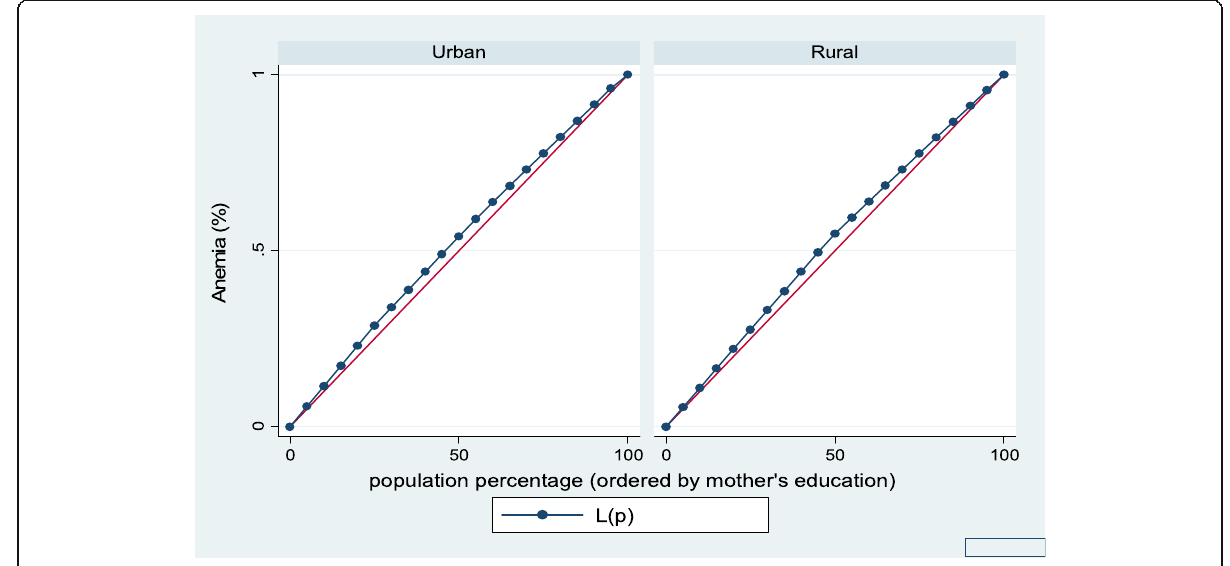
Fig. 11 Urban-rural Lorenz curve for anemia